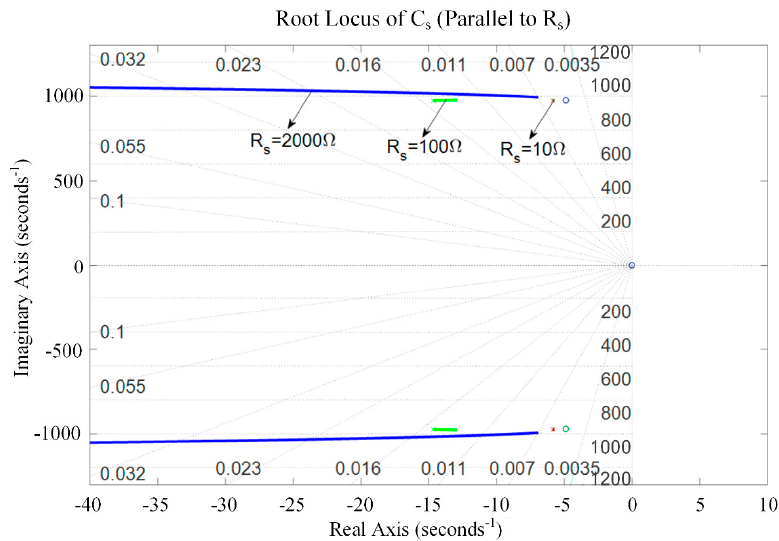
Figure 10. Root locus of the piezoelectric stack transducer with respect to C s for the negative capacitance in parallel with R s .